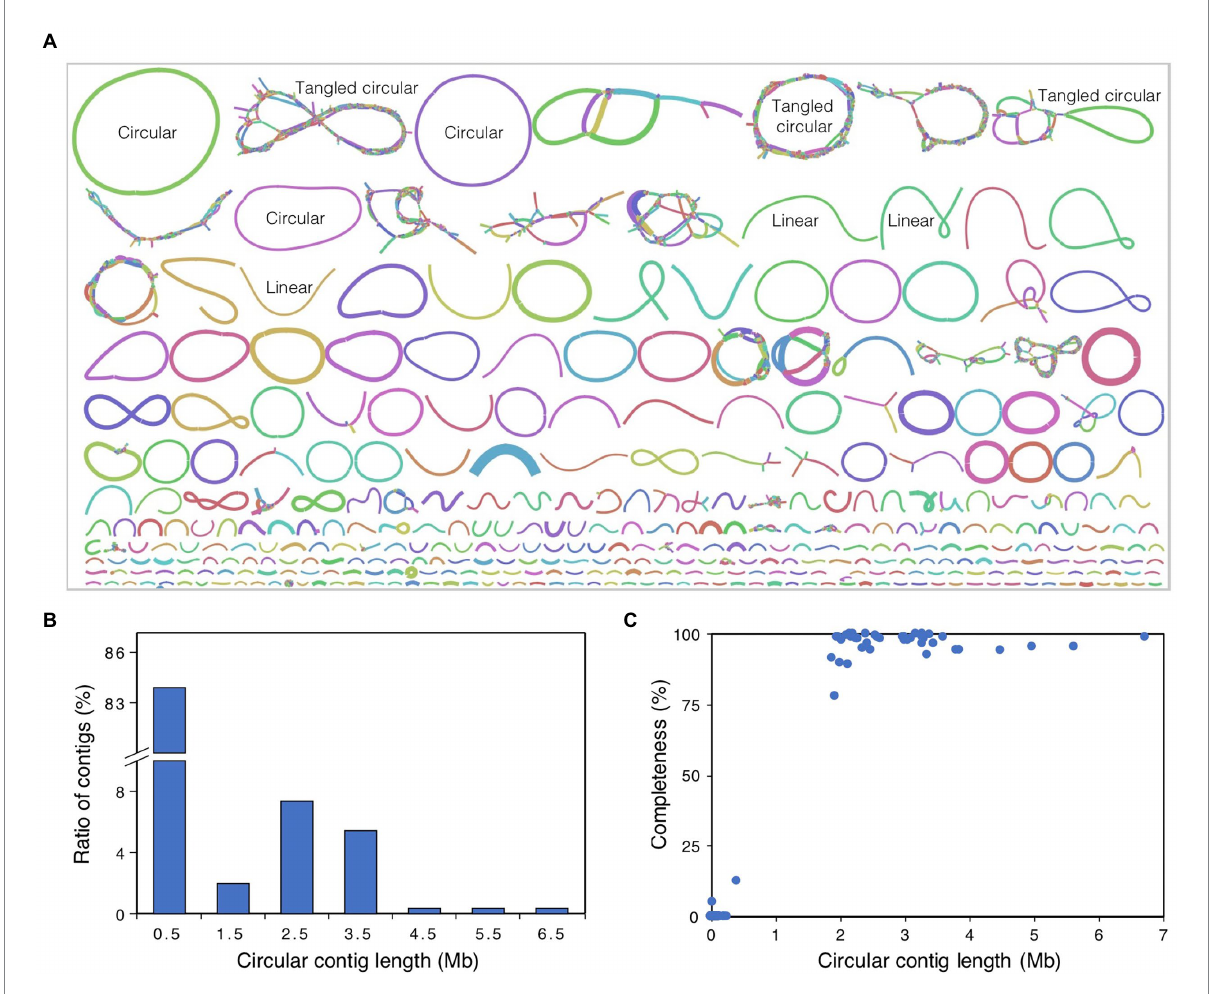
FIGURE 1 Overview of metagenome assembly. (A) Graphic display of the assembled contigs. The graph is drawn by Bandage, and the colors for different contigs are randomly assigned by the software. The line length is in proportion to contig length, and the line width is in proportion to contig coverage depth. Based on the structure of different contigs or contig groups, the contigs were divided into three types, circular contigs, tangled circular contigs, and linear contigs, and some examples were labeled in the figure. Circular contig, one single contig with head and tail concatenated; tangled circular contigs, many linear contigs link to each other and form a big circular or other complex structure; linear contig, one single contig with no link to other contigs. (B) Length distribution of circular contigs. (C) Relationship plot of completeness with contig length for all circular contigs. Completeness value of circular contigs was estimated using